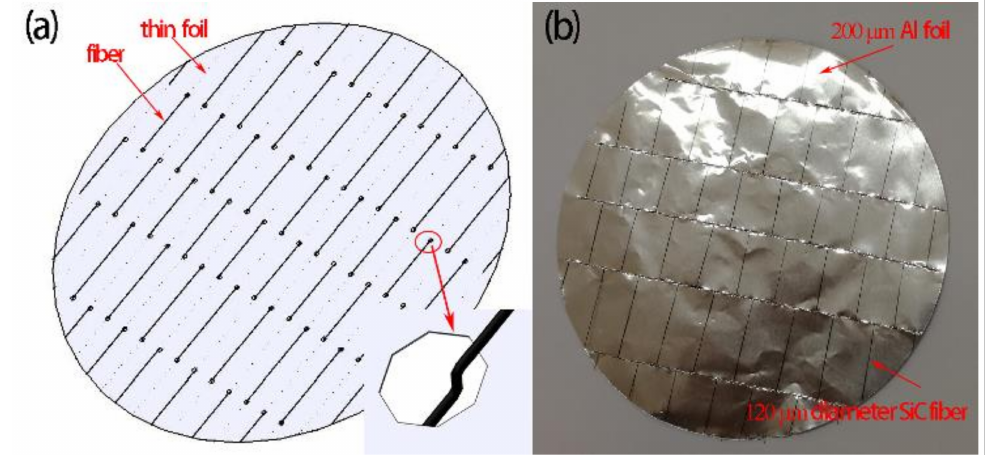
Figure 2. Fiber braid: ( a ) schematic illustration; ( b ) fiber